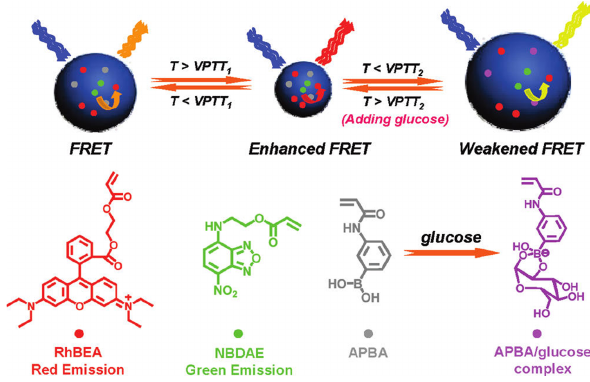
Figure 6: Synthesis and modulation of FRET eflciencies for micro- gels by temperature variations and adding glucose. Reprinted with permission from [42]. Copyright 2011, American Chemical Society